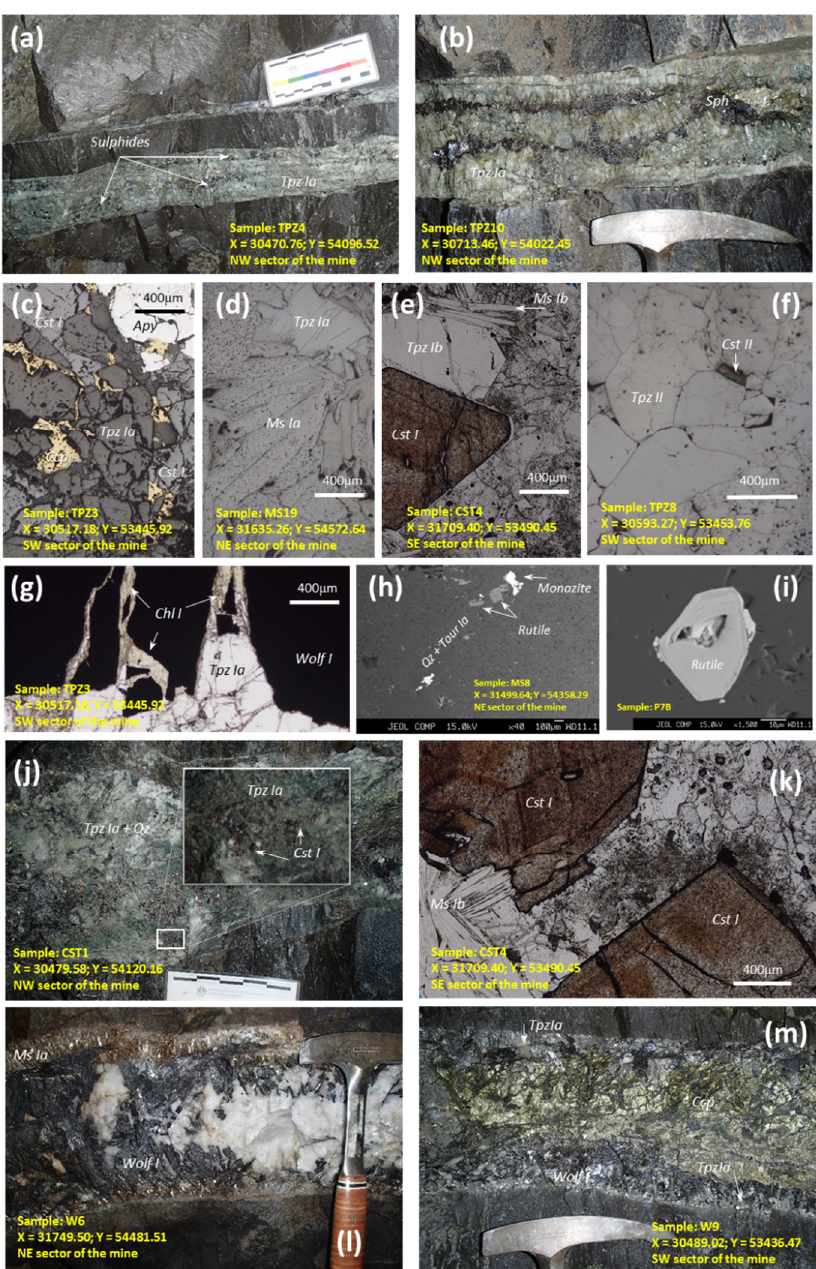
Figure 6. ( a , b ) Photographs of lodes bordered by thick Tpz Ia selvages in the NW sector of the mine, transitional to the SW sector. ( c ) Photomicrograph (reflected microscopy, plane-polarized light) showing the typical fractured arrangement of (variably altered) Tpz Ia and Cst Ia aggregates, subsequently irregularly “invaded” by sulfides (arsenopyrite ( Apy ) and chalcopyrite ( Ccp ), in this case). Photomicrographs (TM / PPL) illustrating the growth of: ( d ) Tpz Ia in coarse-grained Ms Ia selvages of a lode at the NE sectors of the mine; ( e ) Tpz Ib (and Cst I ) in narrow bands of Ms Ib ( + Qz ) decorating the walls of a lode at the SE sector of the mine; and ( f ) Tpz II (and Cst II ). ( g ) Photomicrograph (TM / PPL) illustrating Chl I fracture infillings a ff ecting Tpz Ia and Wolf I . Back-scattered electron images documenting: ( h ) rutile in early-developed cracks adjoining the lode wall, along with Tour Ia , Qz and monazite; and ( i ) zoned rutile grains included in a Tour Ia -rich alteration halo. ( j ) Photograph of the lode wherein the sample CST1 was picked, exemplifying coarse-grained Cst I within Tpz Ia thick selvages. ( k ) Photomicrograph (TM / PPL) representing the typically observed Cst I optical zonation. ( l , m ) Photographs of Wolf I -rich lodes bordered by thick Ms Ia and Tpz Ia selvages, respectively, where the samples W6 and W9 were collected.